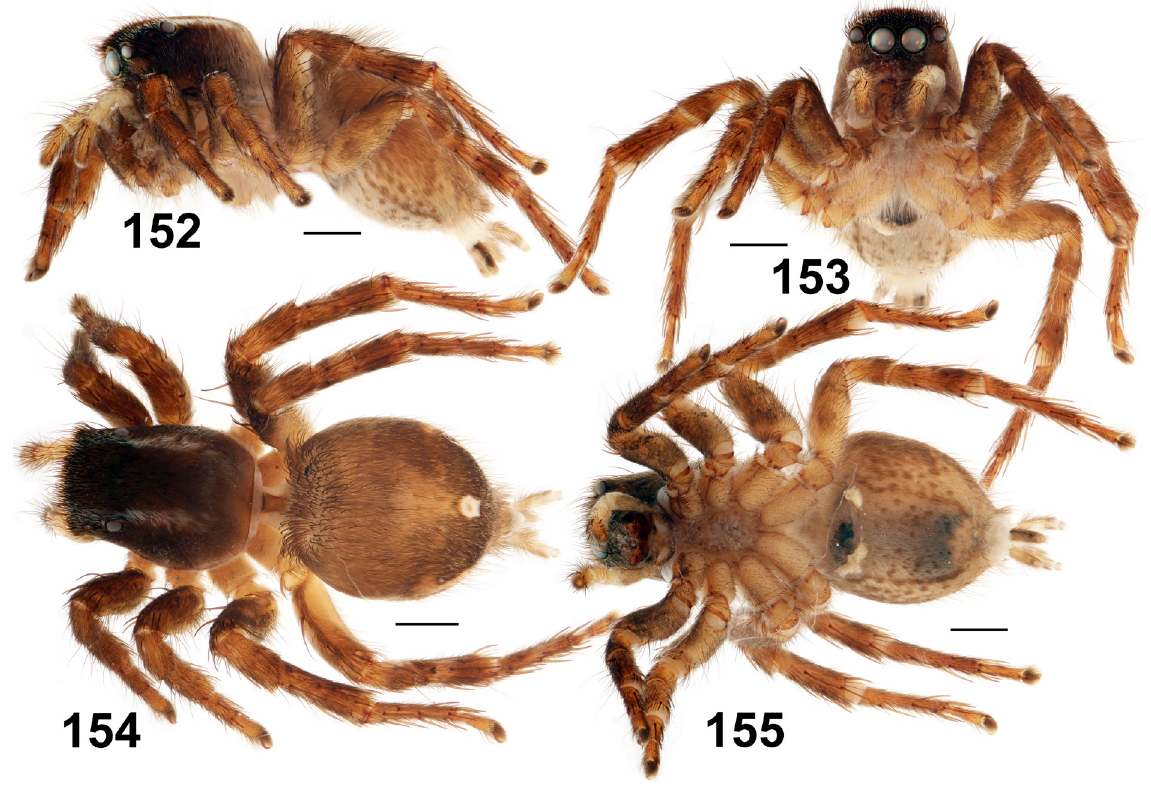
Figs 152–155. ♀ of Stenaelurillus fuscatus Wesołowska & Russell-Smith, 2000 from Kenya (Taita Discovery Centre; MRAC 213.133), general appearance. Scale bars: 1